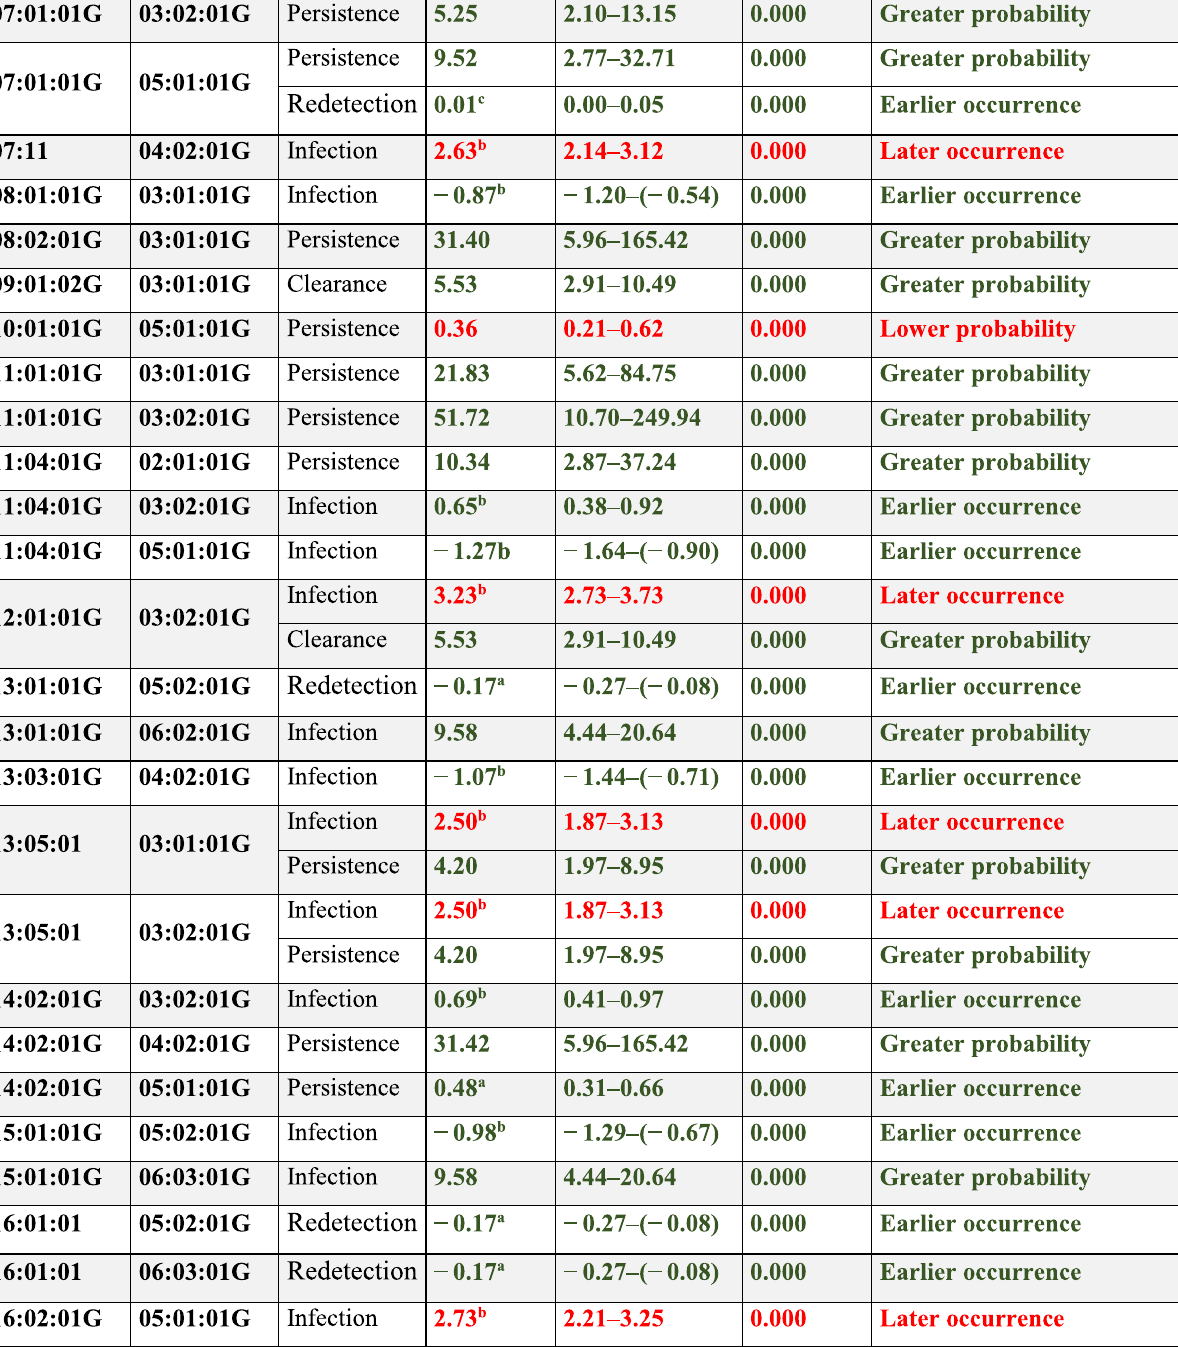
Table 3. HLA DRB1-DQB1 haplotypes associated with Ct infection, clearance, persistence and redetection. Analysis was adjusted for age, age at onset of sexual life, lifetime amount of sexual partners, planning method, abortions, history of other STI and HPV infections. Alleles affecting an event are shown as green associations [i.e. greater probability (GP) or earlier occurrence (EO)] and those hindering them [lower probability (LP) or later occurrence (LO)] as red associations. Values in bold indicate statistical significance based on 95%CI, p < 0.05. Pc corrected p value, 95%CI 95% confidence interval, Coeff regression coefficient, DRB1 DR beta